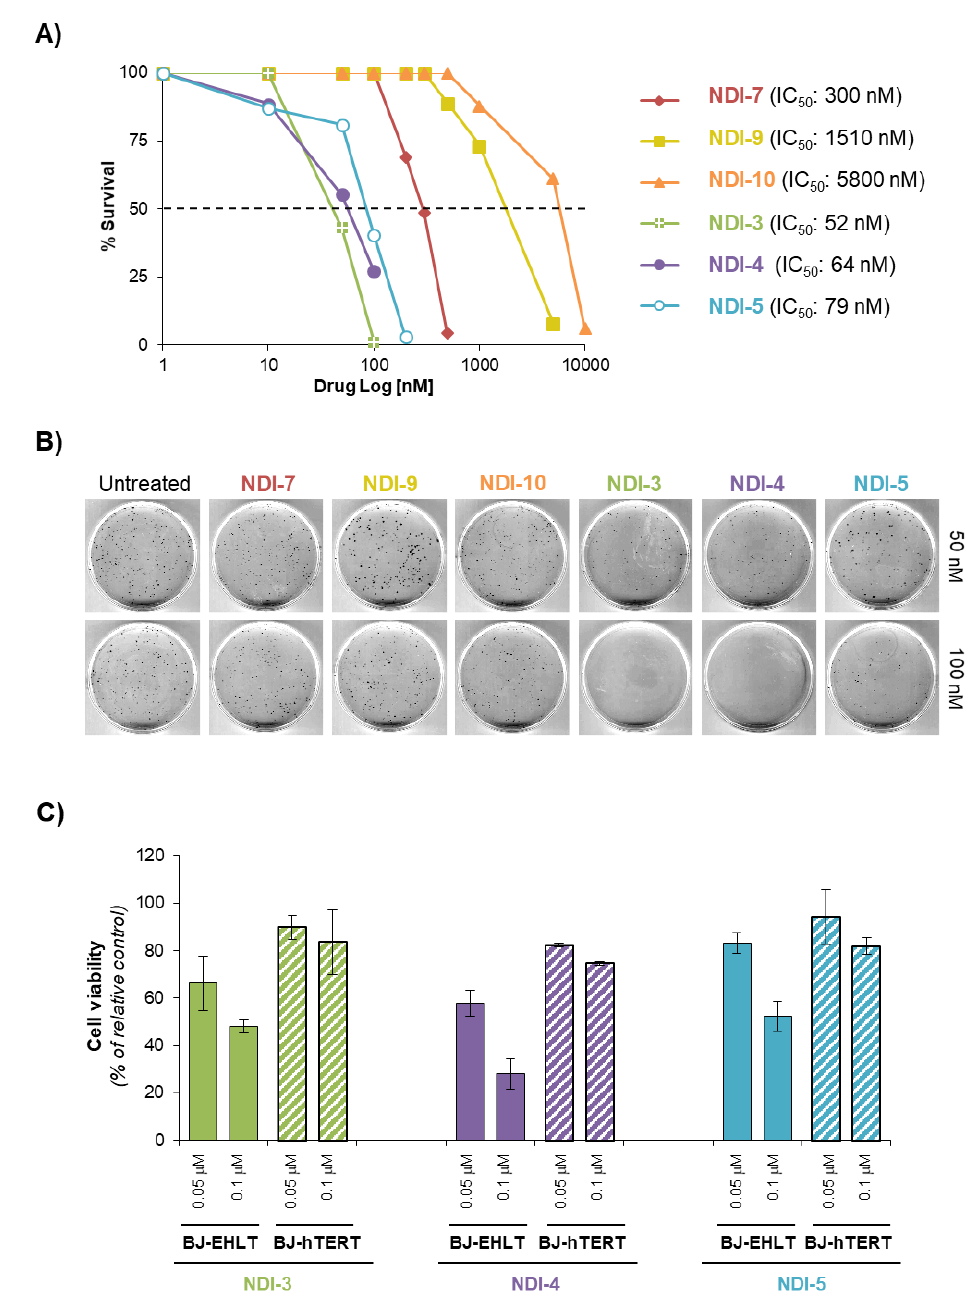
Figure 6. ( A , B ) Clonogenic activity of human cervical cancer cells, HeLa, treated with the di ff erent NDIs at the indicated doses. ( A ) Surviving fractions were calculated as the ratio of absolute survival of the treated sample / absolute survival of the untreated sample. ( B ) Representative images of the clonogenic assay described in ( A ). ( C ) BJ-EHLT and BJ-hTERT cells were treated with compounds NDI-3 , NDI-4 and NDI-5 , at the indicated doses for 24 h. Viable cell number was determined by colorimetric crystal violet assay. Histograms show the mean values ± SD of three independent experiments.